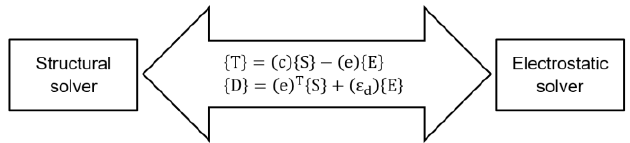
Figure 5. Scheme of coupled solution for electrostatic and structural solver, employing piezoelectric matrix.